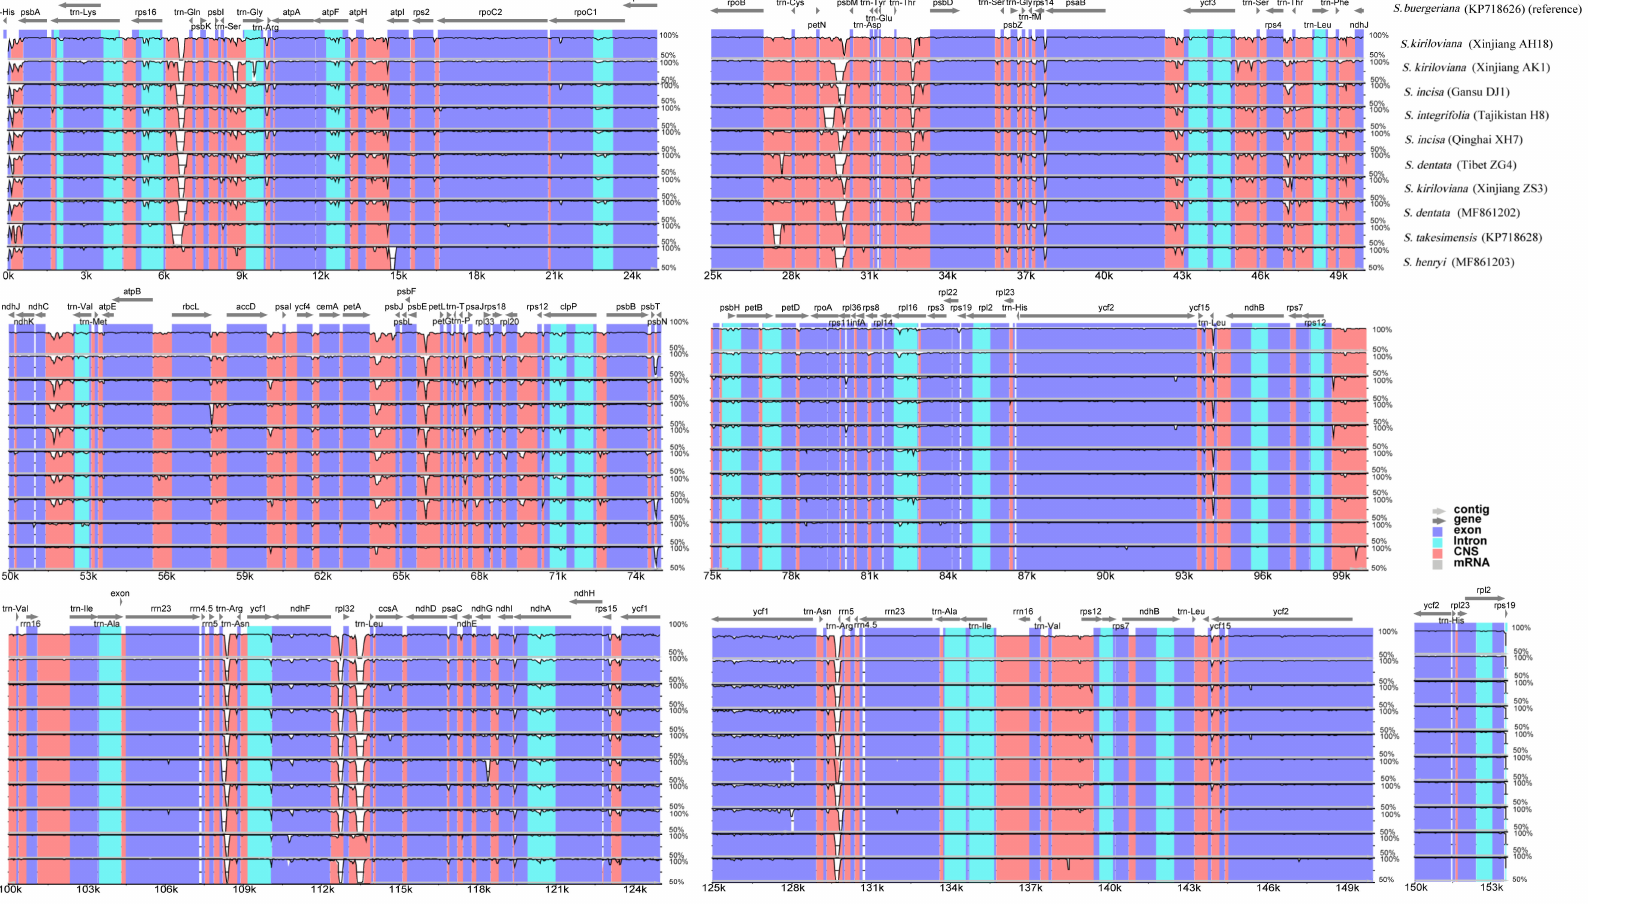
Figure 4. Sequence identity plots among the eleven Scrophularia chloroplast genomes, with S. buergeriana as a reference. Annotated genes are displayed along the top. The vertical scale represents the percent identity between 50 and 100%. Genome regions are color-coded as exon, intron and conserved non-coding sequences